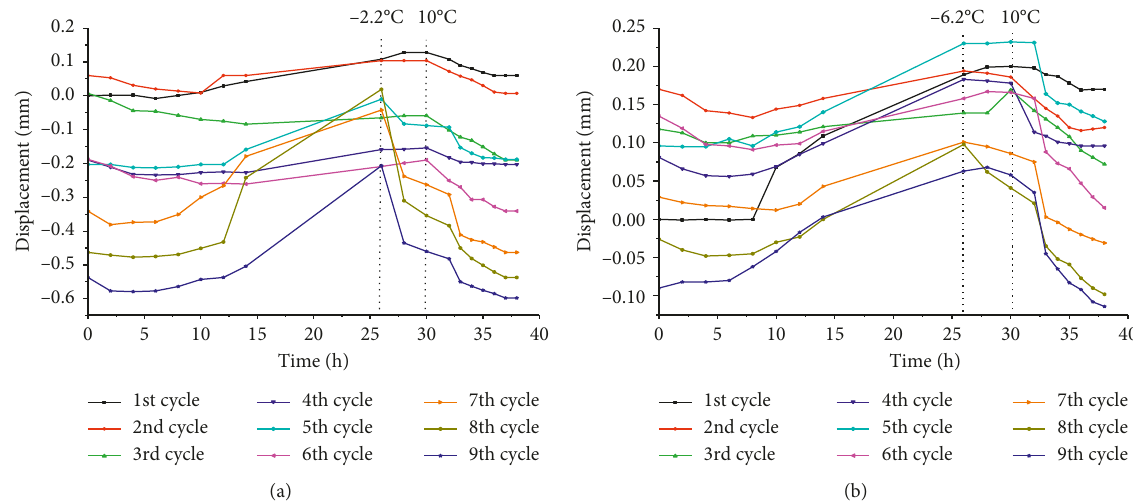
Figure 14: Curves of the deformation with time for (a) 1.5% salt content and (b) 3% salt content.